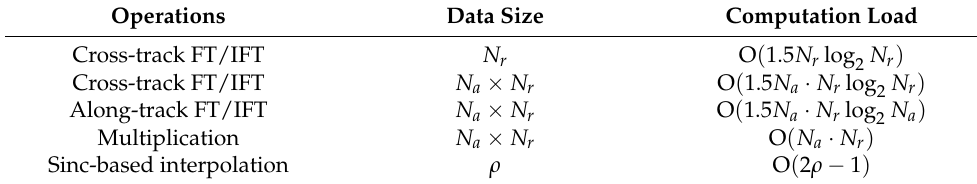
Table 3. Computation load of basic operations.